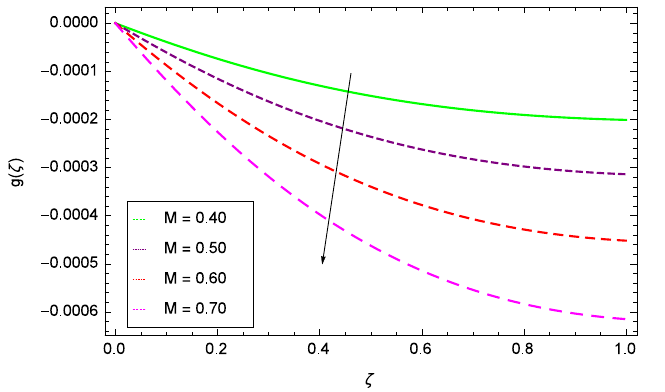
Figure 16. Parameter effect on velocity g ( ζ ) profile.